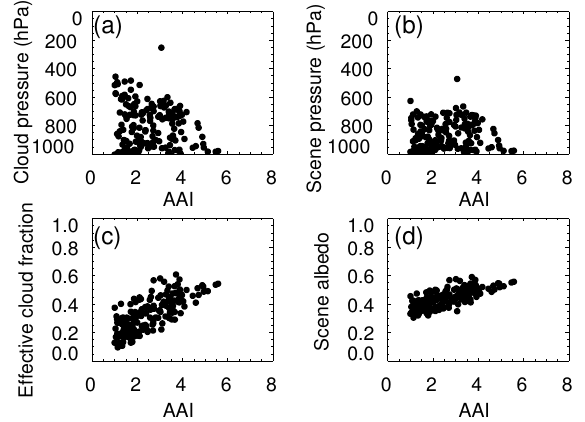
Fig. 19. Scatter plots of FRESCO (a) cloud pressure, (b) scene pressure, (c) effective cloud fraction, and (d) scene albedo versus absorbing aerosol index (AAI) from GOME-2 measurements of the Russian wild fire smoke event on 1 August 2010 around 06:50UTC. The pixels used in the scatter plots are marked with a box in Fig. 18 in the region of [52, 60] ◦ N and [35, 56] ◦